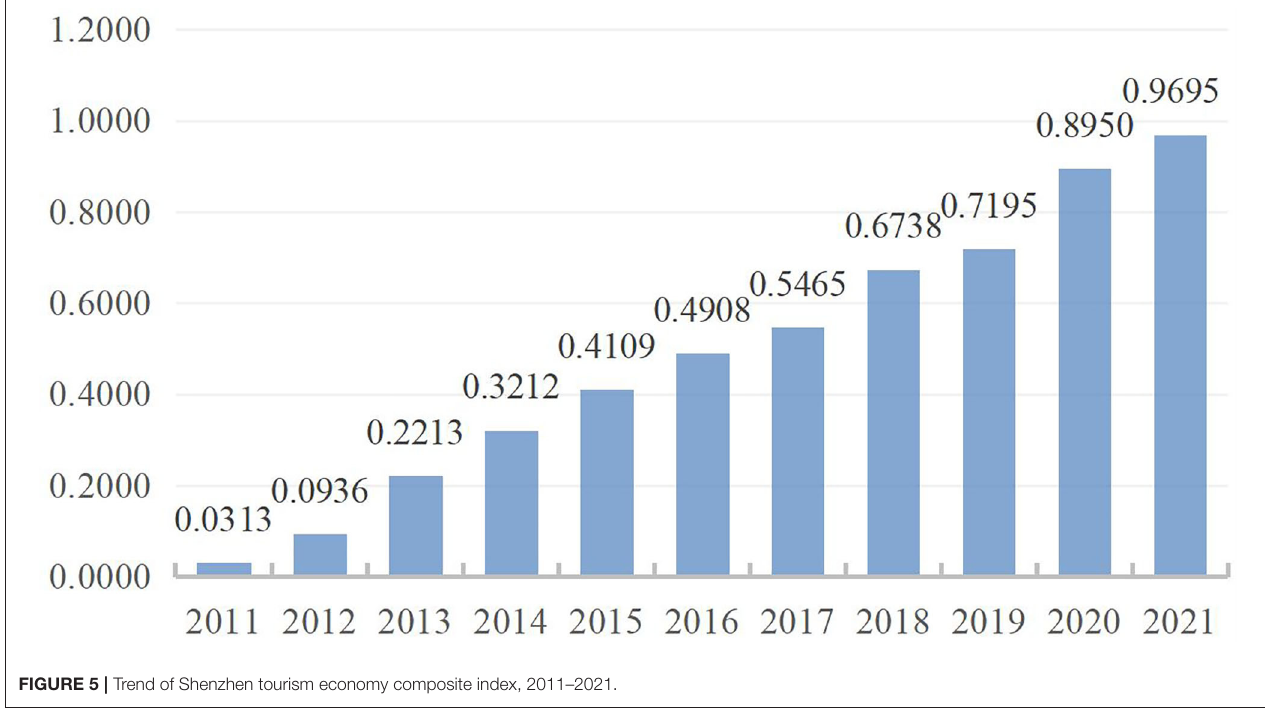
FIGURE 5 | Trend of Shenzhen tourism economy composite index, 2011–2021.